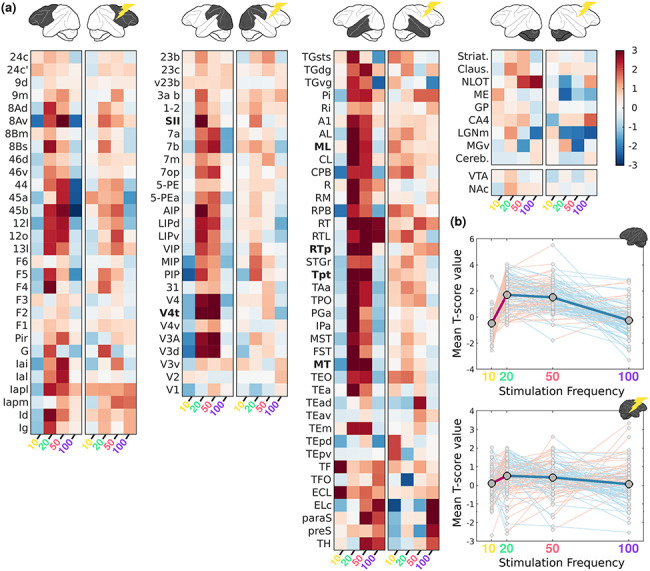
ROI analysis of VTA stimulation-induced activity as function of frequency in awake monkeys. (a) Heat maps of fMRI activity (mean t-score values) for ROIs in the left and right hemispheres as function of stimulation frequency. ROIs are derived from the D99 atlas and divided into: frontal, parietal-occipital, temporal and subcortical subdivisions (top left to right). The small yellow lightning icon marks the stimulated hemisphere. ROI names in bold are those in which the strength of the activity survived a stringent statistical threshold (P < 0.0001) for one of the frequencies and can be considered most affected by VTA-EM (b) Mean t-score values (gray circles) for anatomical ROIs combined for the left, unstimulated, (top) and right, stimulated, hemispheres (bottom). Connecting lines between each of the ROIs indicate an increase (pink) or decrease (light blue) in activity between neighboring stimulation frequencies. The thick central line and larger circles show the mean values across all ROIs.